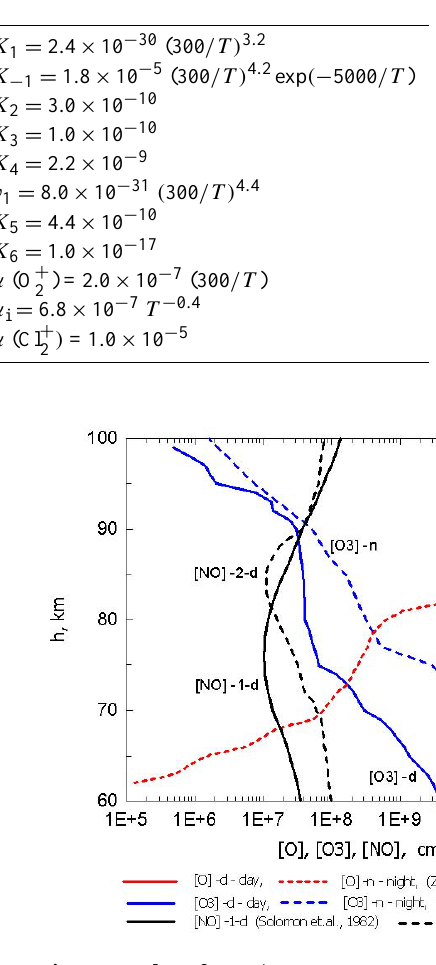
Fig. 1. Profiles of atomic oxygen, ozone and nitric oxide in the mesosphere used as model input